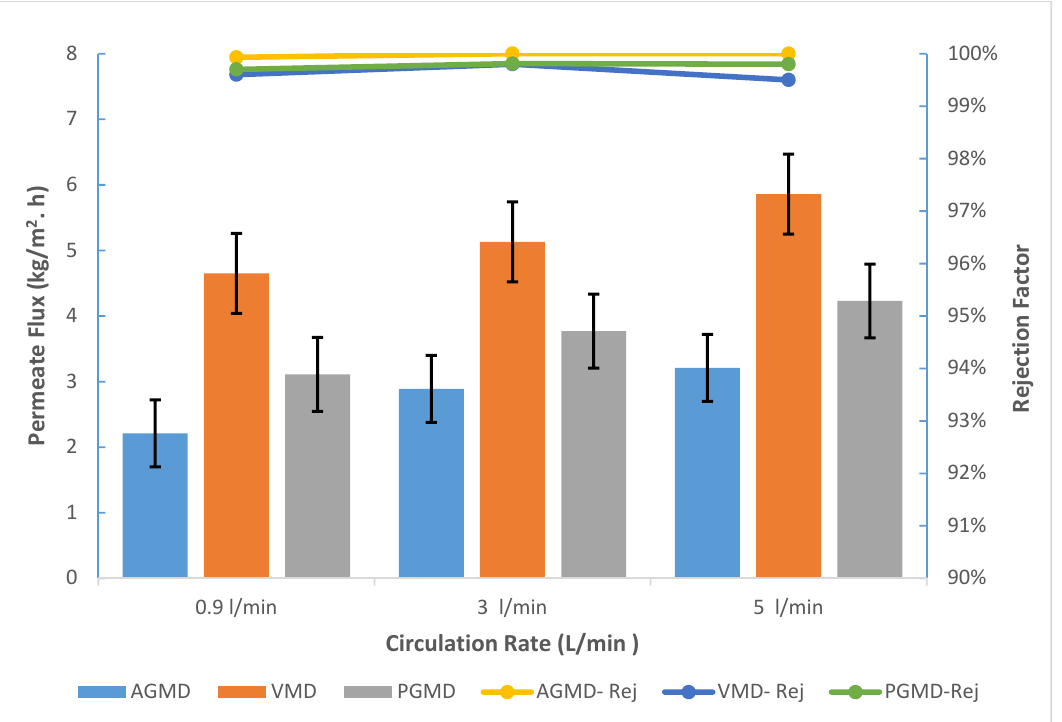
Figure 8. Permeate flux and salt rejection for AGMD, PGMD, and VMD for synthetic seawater.